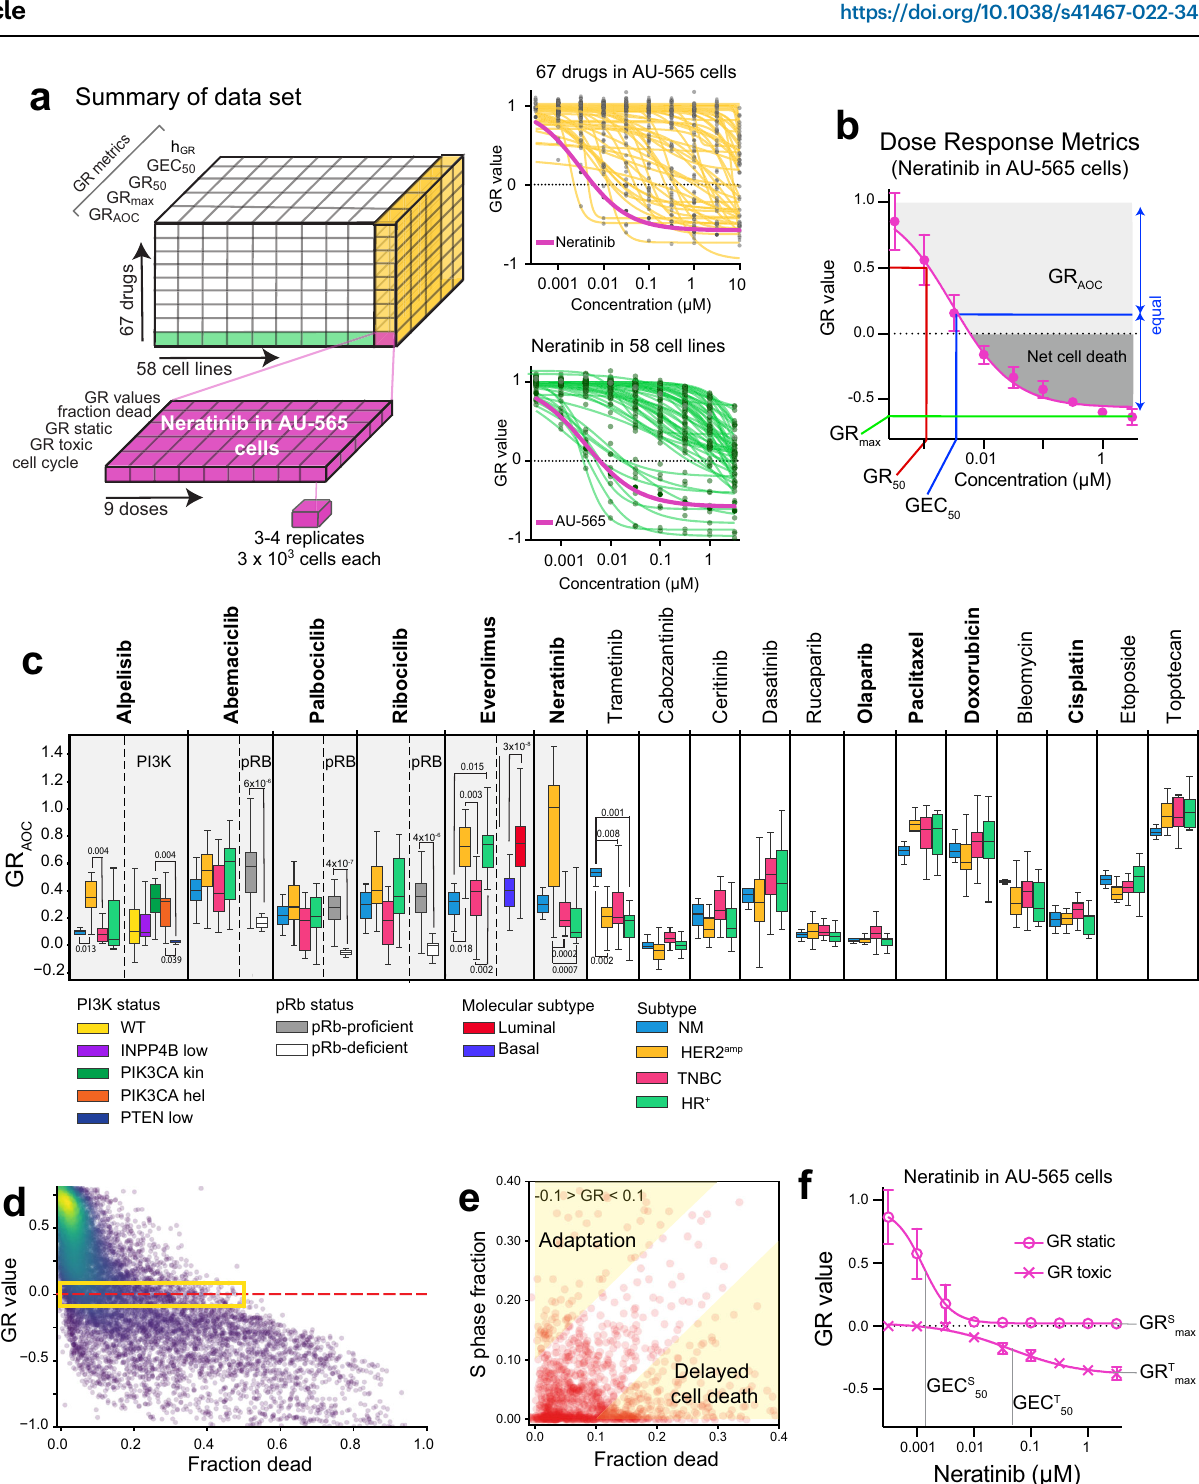
show the fi rst and third quartiles, the bar within each box represents the median value anderrorbarsrepresentthe rangeof values. P -valuesfrom2-wayANOVAwith Tukey ’ s correction for multiple comparisons, or unpaired 2-tailed t-test when only comparing two groups are shown for signi fi cantly different comparisons. The sha- ded region indicates responses that align with known biomarkers. d Variability in fractiondeadwithrespecttoGRvalueforalldoseresponsedata,GRvalues>0.8are not shown. e Fraction of cells in S-phase relative to fraction dead for conditions resultingin − 0.1>GR<0.1.Regionsindicativeoflate-onsetcelldeathandadaptation to drug are highlighted in yellow. f GR S and GR T curves for AU-565 cells treated with neratinib. Data are presented as mean +/ − standard deviation of technical quad- ruplicates. Source data are provided as a Source Data fi le and on